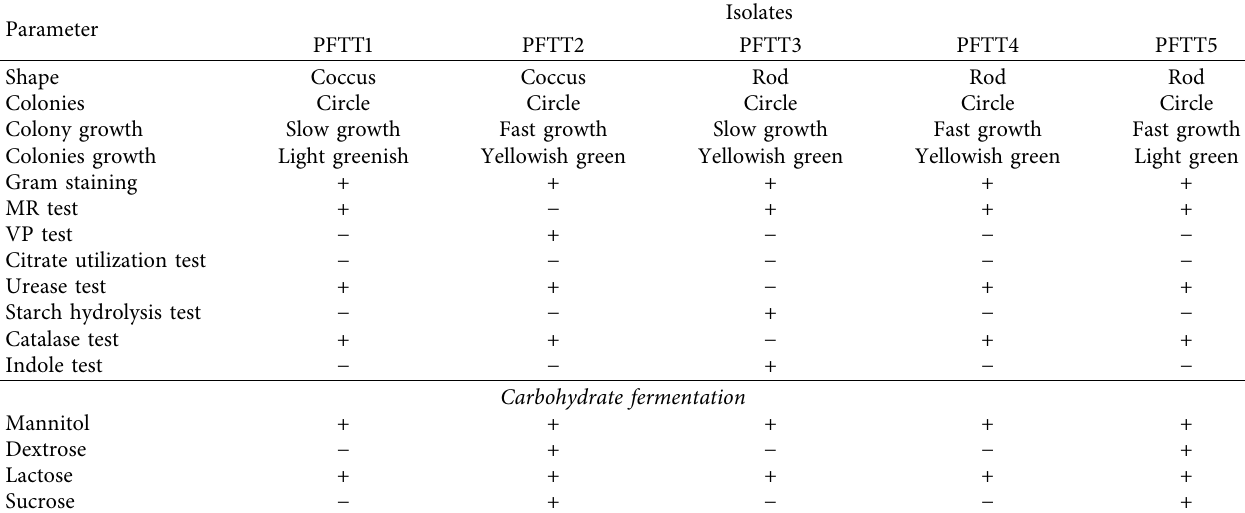
Table 1: Morphological and biochemical characterization of Pseudomonas fluorescens